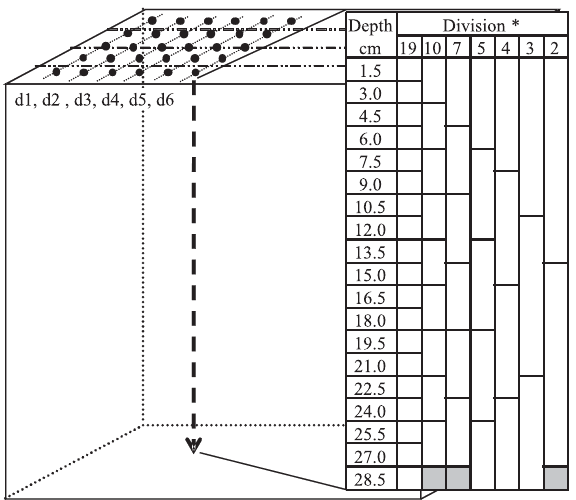
Figure 1. Schematic experimental unit with distribution of PR measurements (points are in perpendicular direction to the planting rows), and the divisions of PR profile in layers. d1, d2, d3, d4, d5, and d6 that refer to the measurements on the following dates, respectively: Feb 20, 22, 24, and 25 and Mar 5 and 6. *In some divisions (3, 4 and 5) the deeper layers were less thick; data of grayish mottled regions were not included in the